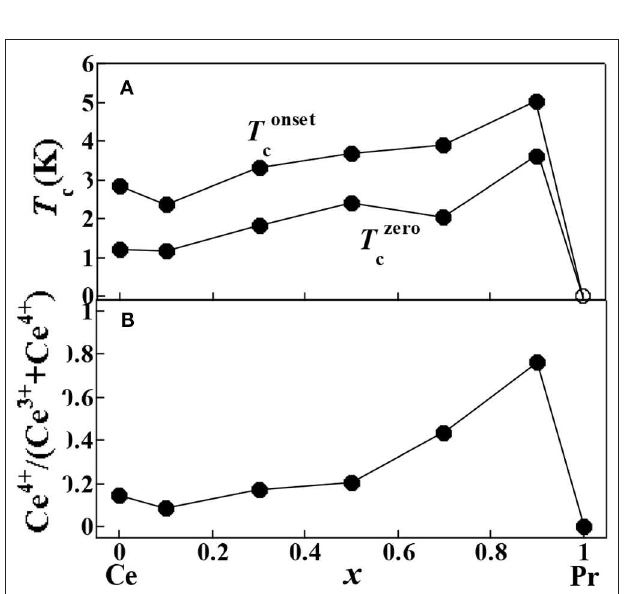
FIGURE 6 | Temperature ( T ) dependence of resistivities normalized at 15K [ ρ / ρ (15K)] for (Ce,Pr)OBiS 2 with 0 ≤ x ≤ 0.9 single crystals in the temperature range of 0.25–15K. The data of x = 0 was referred from the literature (Nagao et al., 2016).